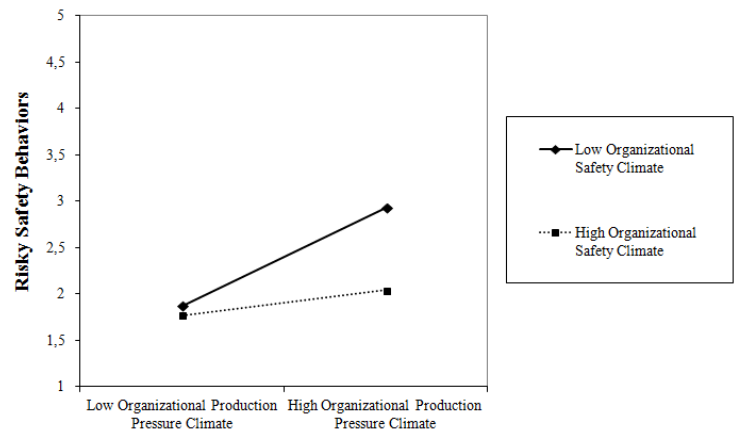
Figure 3. Plots of the Interaction Among Safety and Production Pressure Climates from the Final Multilevel Model.